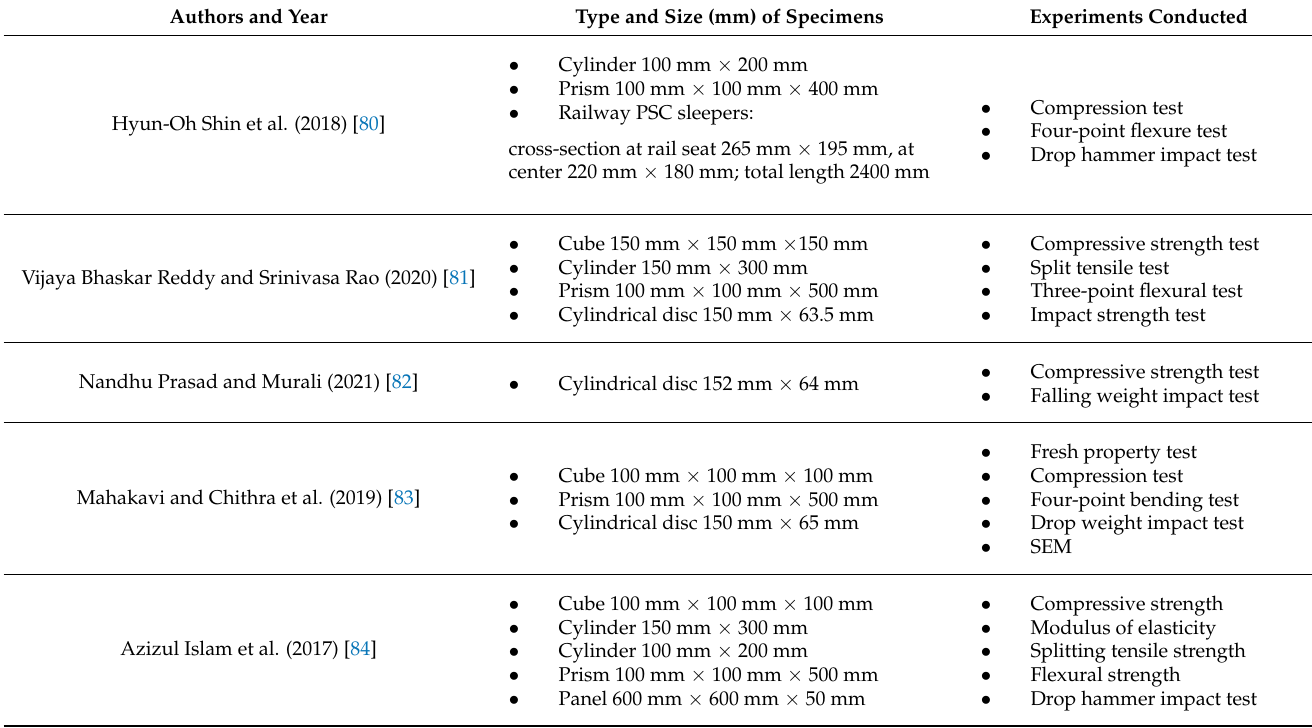
Table 3. The majority of studies examining the impact resistance properties of steel